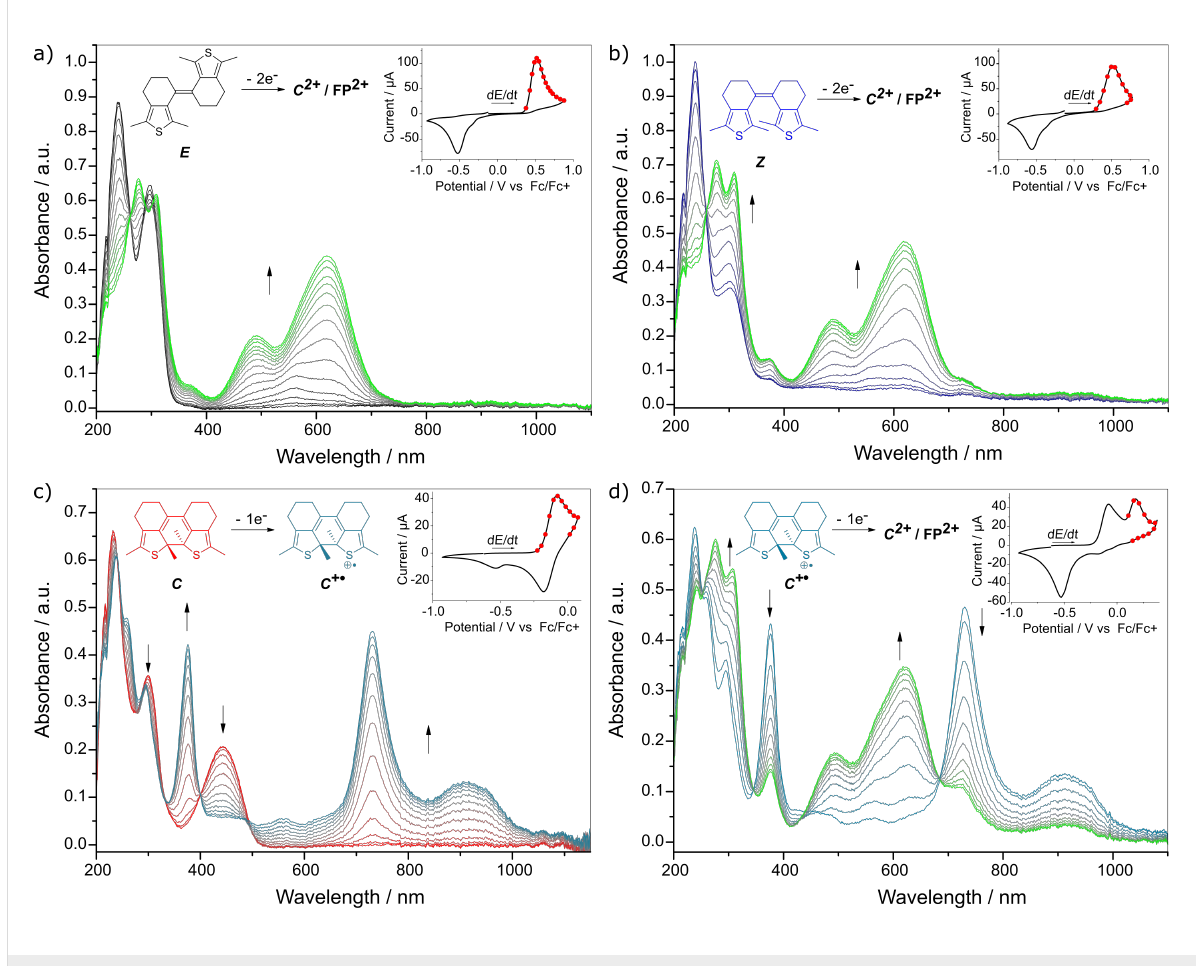
Figure 2: Spectroelectrochemistry of sDTE 66 -Me . Absorption changes during CV, insets showing the corresponding cyclovoltammograms with red dots marking when UV–vis–NIR spectra were measured. A stable intermediate is formed upon oxidation of: a) E- sDTE 66 -Me and b) Z- sDTE 66 -Me . c) Oxidation of photogenerated C- sDTE 66 -Me to the stable radical cation C +• . d) Further oxidation of C +• to the dication FP 2+ , measured in a separate experiment. At the low sweep rates of SEC an irreversible reduction wave at E pc = − 0.530 V occurs in a), b), and d). Experiments were carried out in MeCN with 0.1 M Bu 4 NPF 6 , c = 5 ∙ 10 − 4 M, dE / dt = 10 mV s − 1